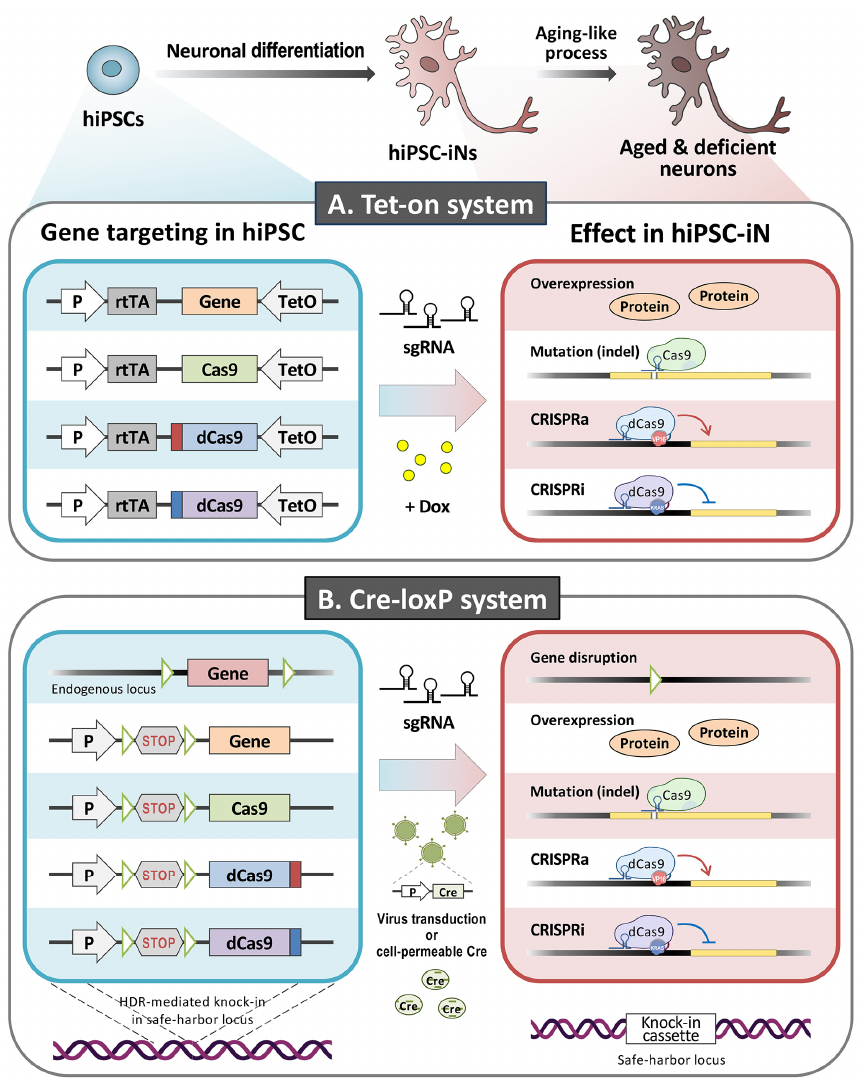
Figure 3. Schematic of the inducible system in hiPSC-iNs. The inducible functional cassette is knocked into a genomic safe harbor (e.g., AAVS1) in the hiPSCs via CRISPR/Cas9-mediated homology-directed repair (HDR). The temporal control of gene expression or inactivation is achieved by the addition of doxycycline (Dox) ( A ) or Cre protein ( B ), respectively, either to the hiPSCs or the hiPSC-iNs. The figure was created with Biorender.com accessed on 19 October